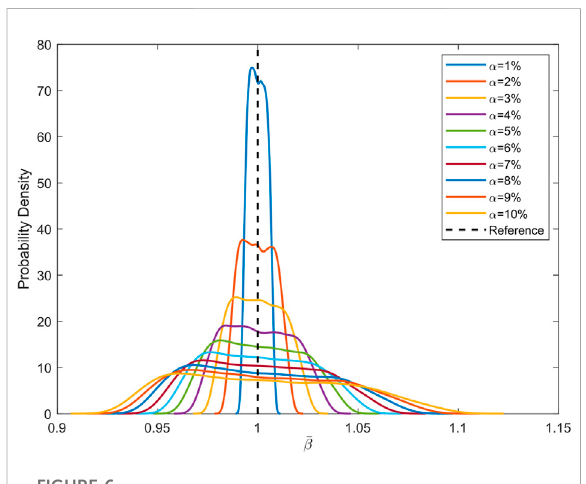
FIGURE 6 Probability density function with disorder strength varies from 1% to 10%. For each situation, the PDF is estimated from the results of 2 × 10 4 samples. The reference line indicates (cid:2) β (cid:2) 1.